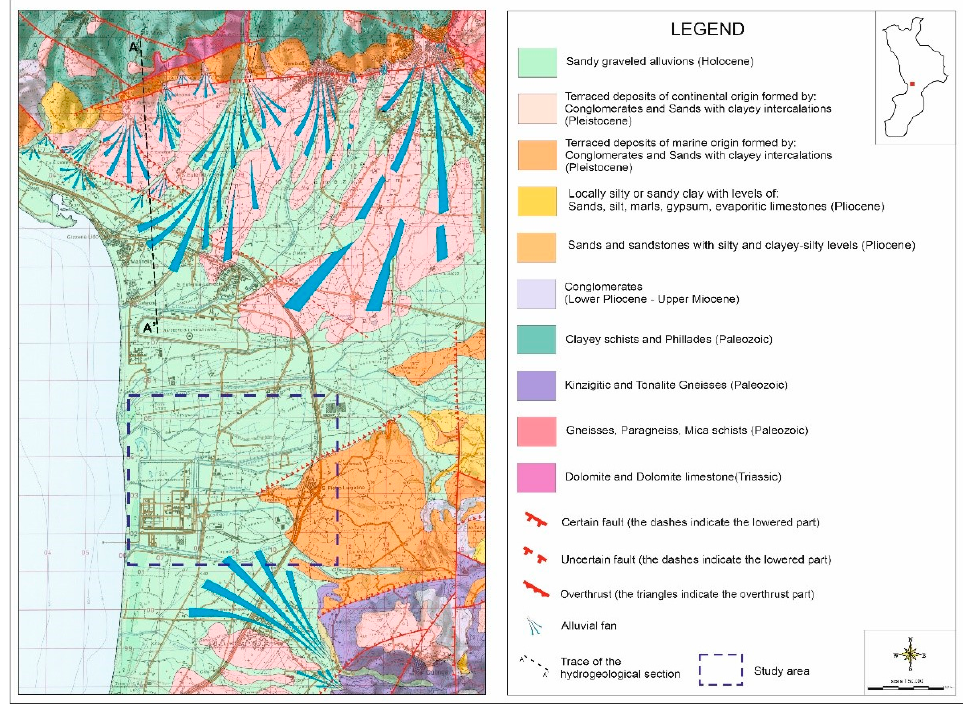
Figure 3. Structural Lithological Map of the S. E. Lamezia Plain (Modified) [11].